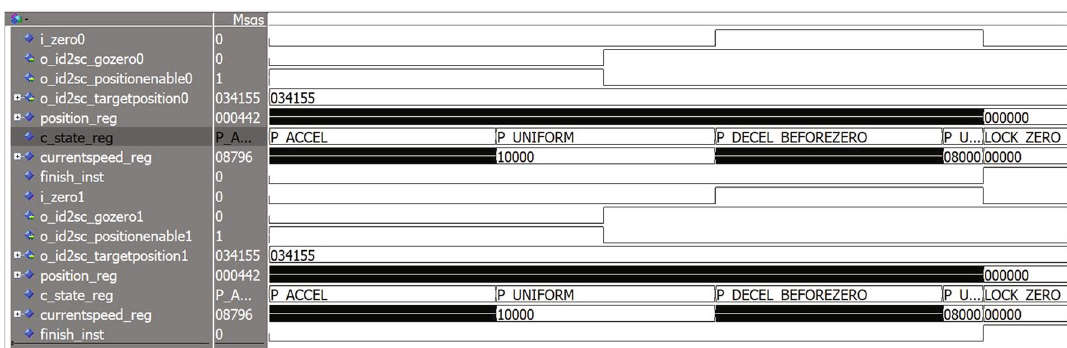
Figure 10: Simulation waveform of go to zero-position during 60 ° angle regulation.